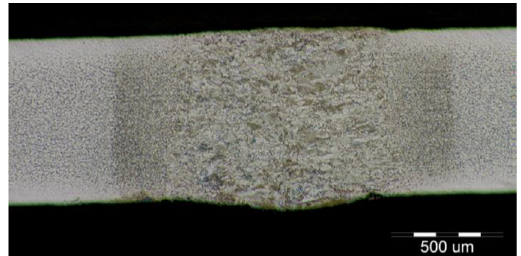
Figure 7. Macrostructure of sample A welded joint (HSLA).